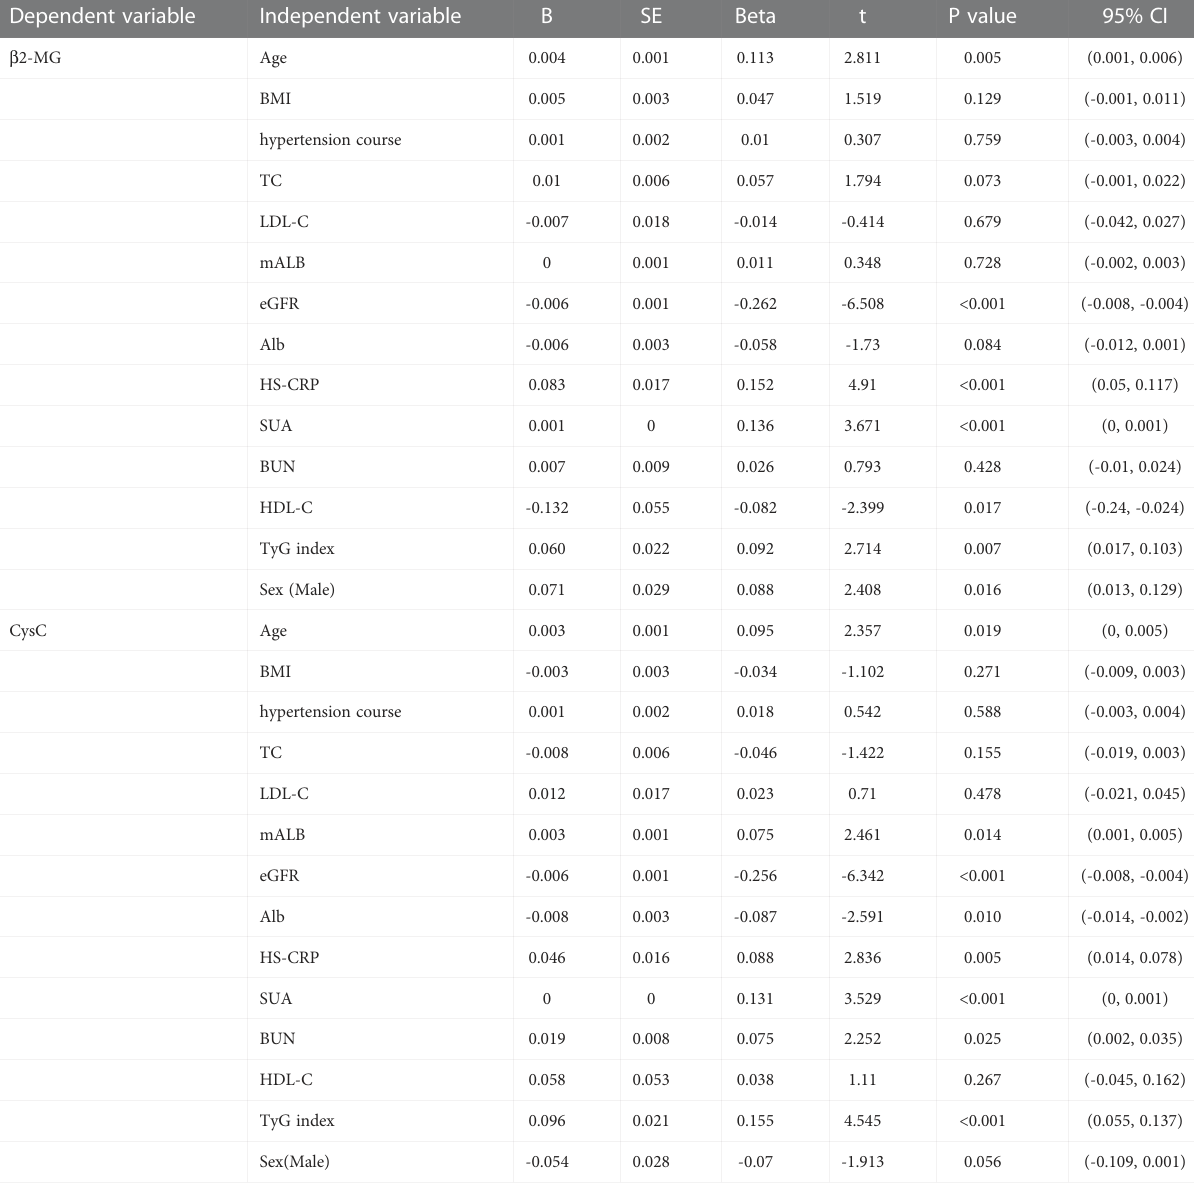
Abbreviations as given in Table